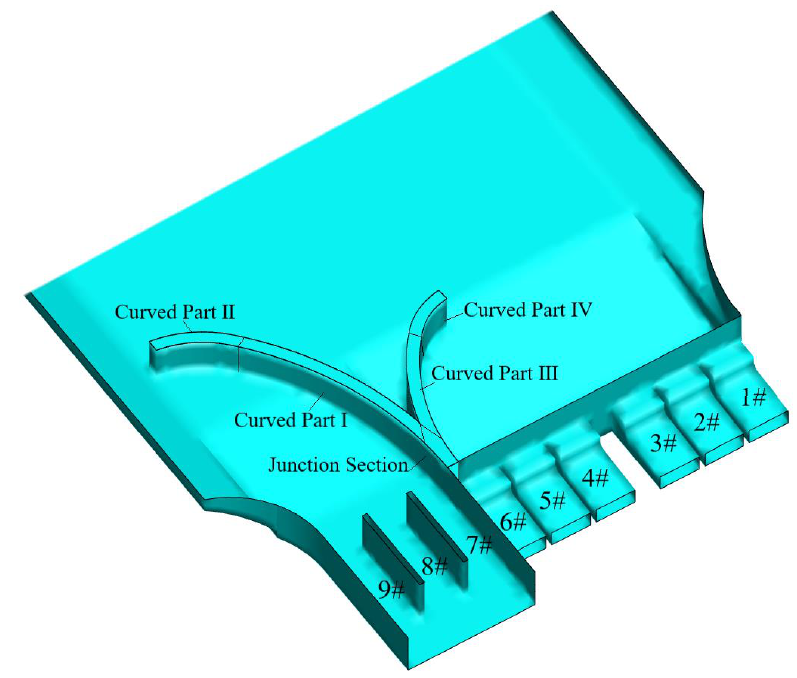
Figure 3. Layout plan of the training wall.